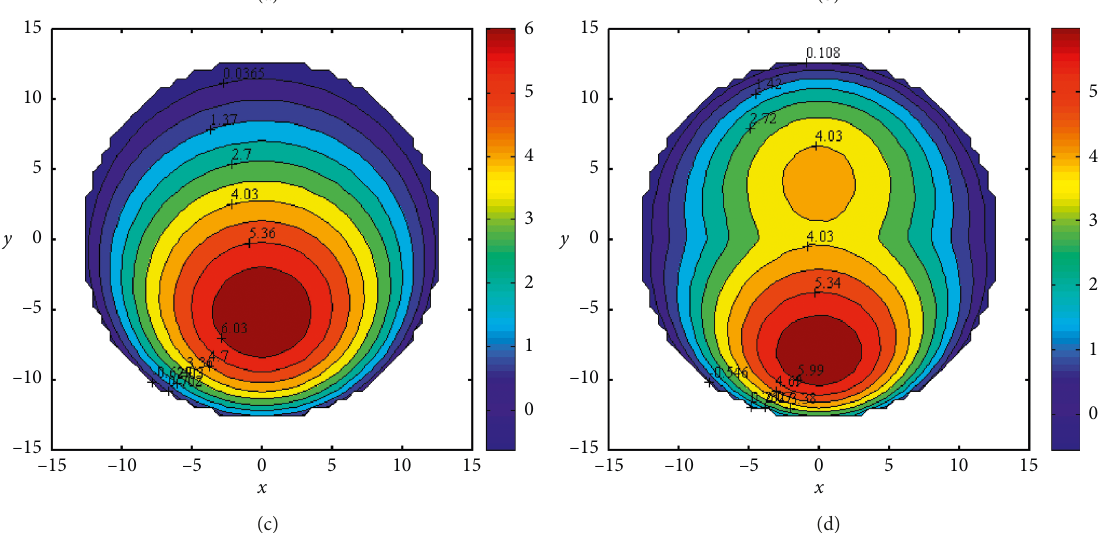
Figure 3: (a) The front view and left view of deformation displacement contour maps of one direction incline membrane under a pressure of 106Pa. (b) The front view and left view of deformation displacement contour maps of two directions incline membrane under a pressure of 167Pa. (c) The mean power distribution of one direction incline membrane under a pressure of 106Pa. (d) The mean power distribution of two directions incline membrane under a pressure of